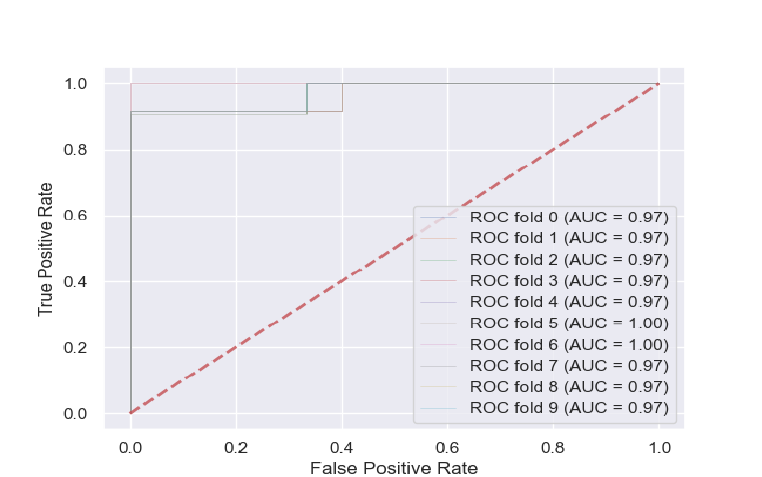
Figure 1. Logistics Regression ROC Curve for every 10-Folds Cross-Validation Training